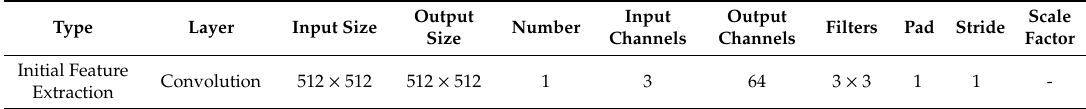
Table 1. The parameters configuration of the proposed network. “Tanh” denotes a hyperbolic tangent